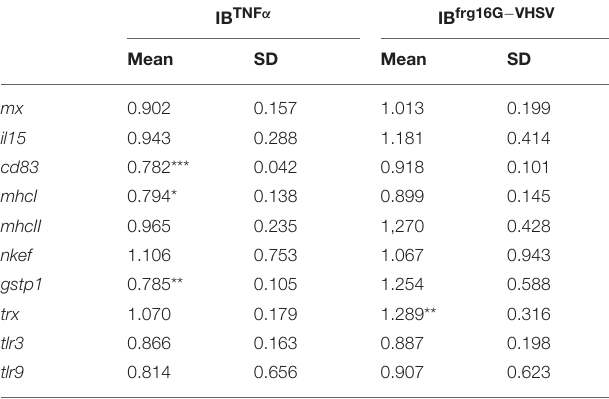
TABLE 2 | Immune-gene expression analysis of RBCs stimulated in vitro with 50 µ g/mL of IB iRFP , IB TNF α and IB frg16G − VHSV at 24h